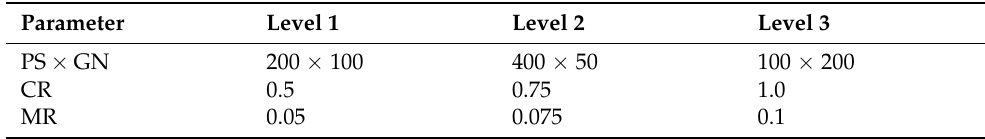
Table 2. Levels of key parameters for